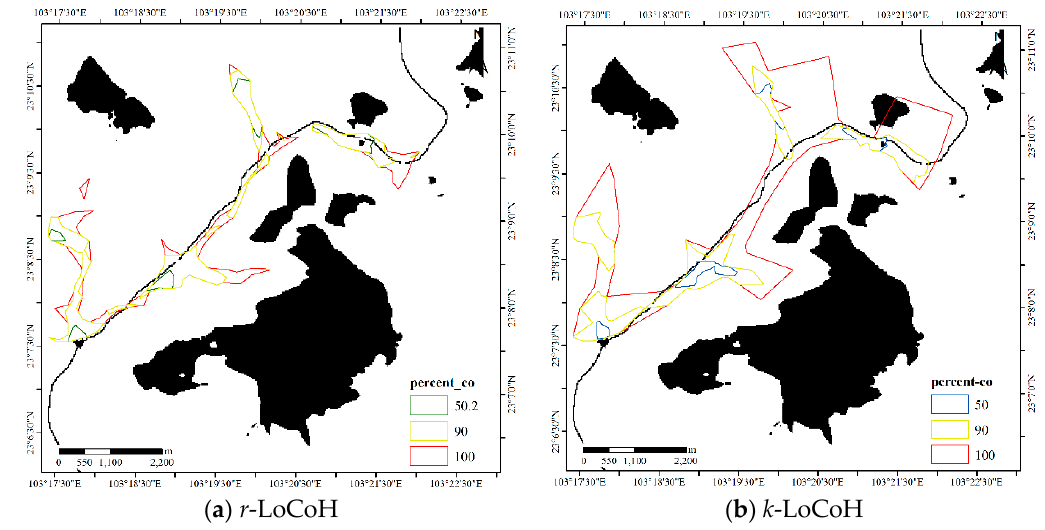
Figure 16. HRs from the LoCoH methods for Dataset 2.